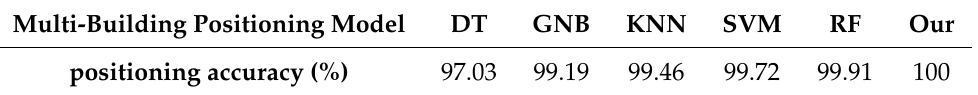
Table 3. Comparison of our algorithm and machine learning methods for multi-building positioning. Multi-Building Positioning